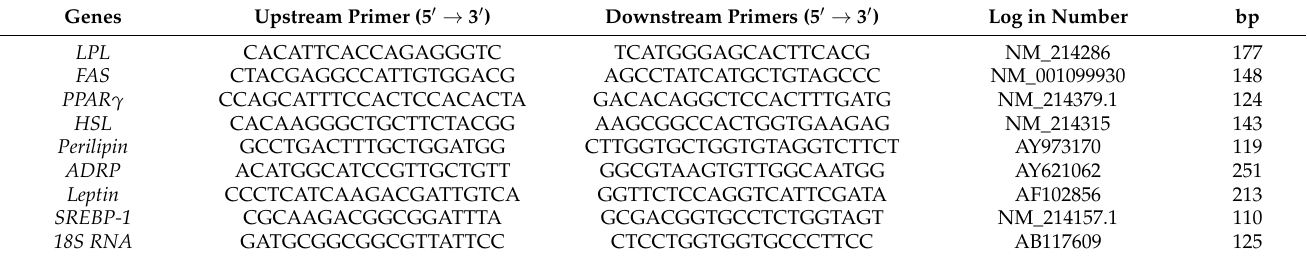
Table 2. Primer sequences.